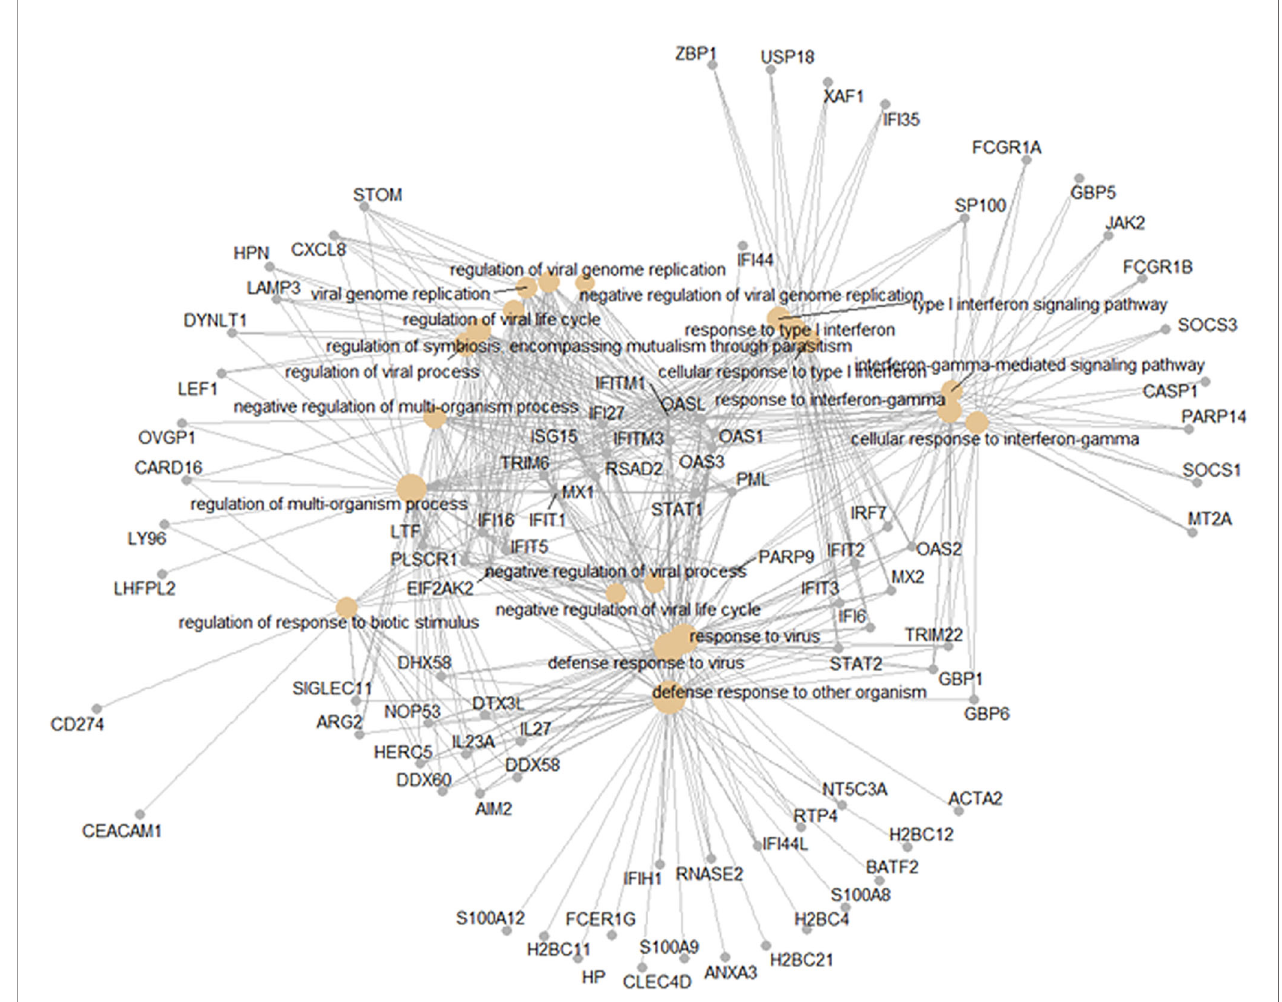
FIGURE 8 | Pan-viral host response. Functional analysis using GO term enrichment for the overlapping 427 DEGs from the Venn diagram of the contrasts of all infections versus healthy controls. Network of top 20 pathways and associated